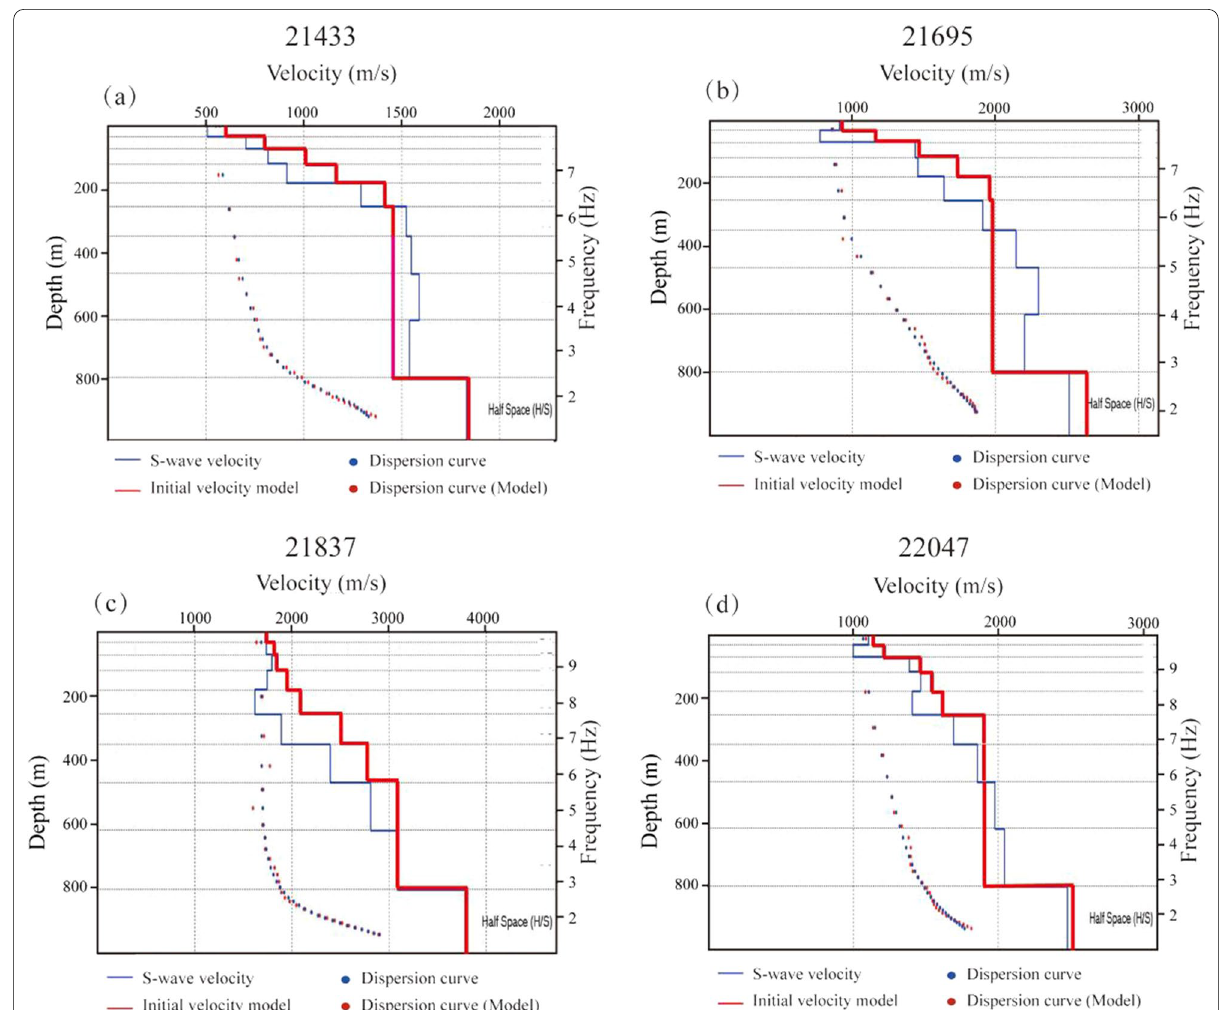
Fig. 5 Inversion results of S-wave velocity at different shot points. Red line is initial velocity. Blue line is inverted S-wave velocity